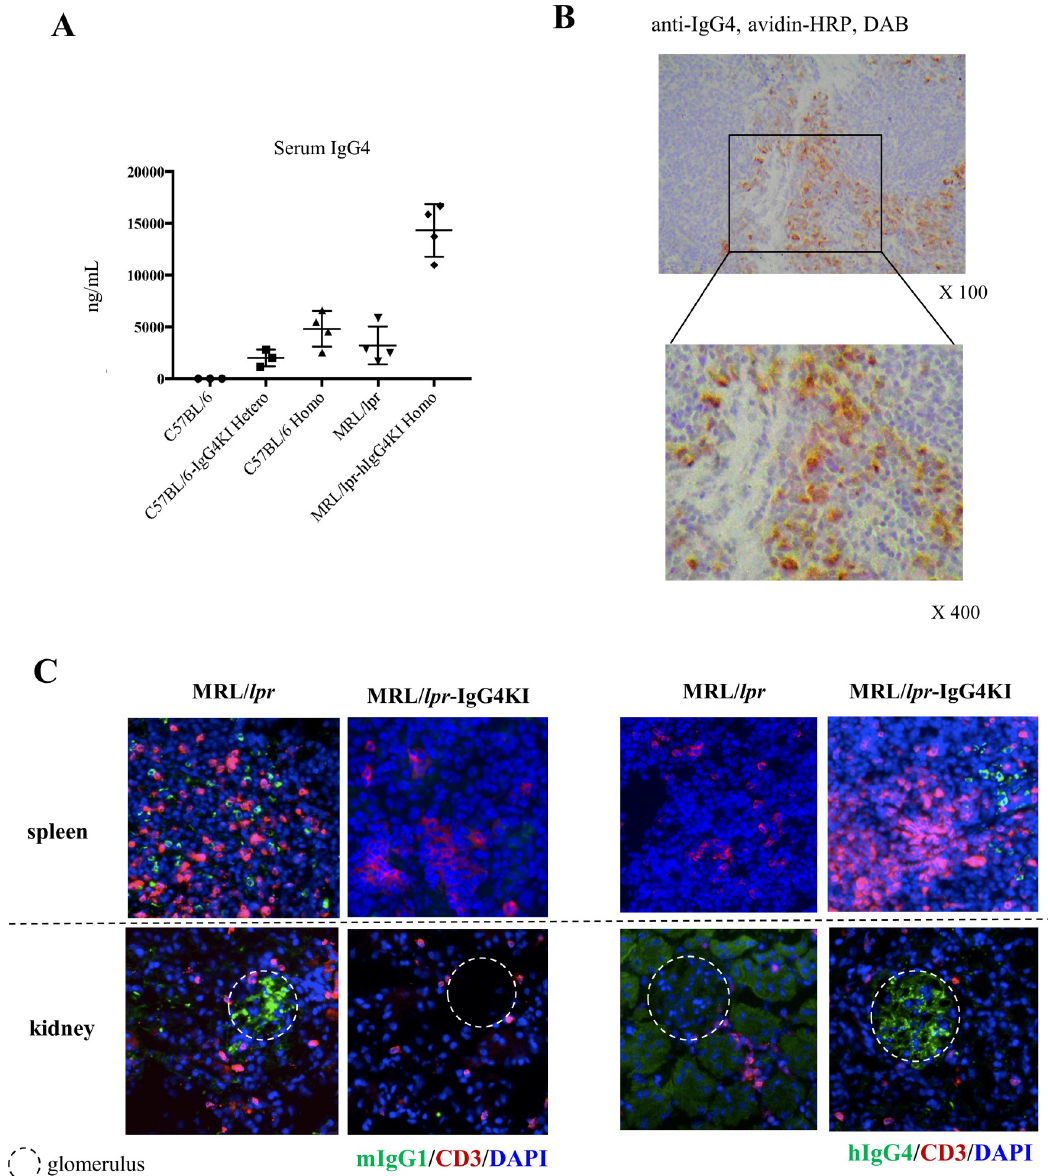
Fig 2. Protein expression of hIgG4 in MRL/lpr-hIgG4KI mice. A. Serum hIgG4 concentration. B. IgG4-positive cells in erythrosplenic medulla of MRL/lpr-hIgG4KI mouse spleen (16-week-old) as assessed by labelled streptavidin biotinylated antibody (LSAB) staining. C. Immunostained IgG4 + cells in 8 to 16-week-old mice. Circle indicates glomerulus. ( P = 0.0041). No difference was observed in lymphocyte percentages between the two strains of mice (Fig 4A and Gating strategies were shown in S7 Fig in S1 File). We found that the per- centage of CD3 + B220 − CD4 + single-positive (SP) cells was significantly decreased in the MRL/ lpr-IgG4KI mice (Fig 4C). In the CD4SP population of the MRL/lpr-hIgG4KI mice, there tended to be an increased population of central memory (CM) T cells (Fig 4F) and decreased population of effector T cells (Fig 4E) than in the CD4SP population in MRL/lpr mice. The percentage of CD8SP cells (Fig 4D), the ratios of na ï ve, CM, and effector cells did not differ